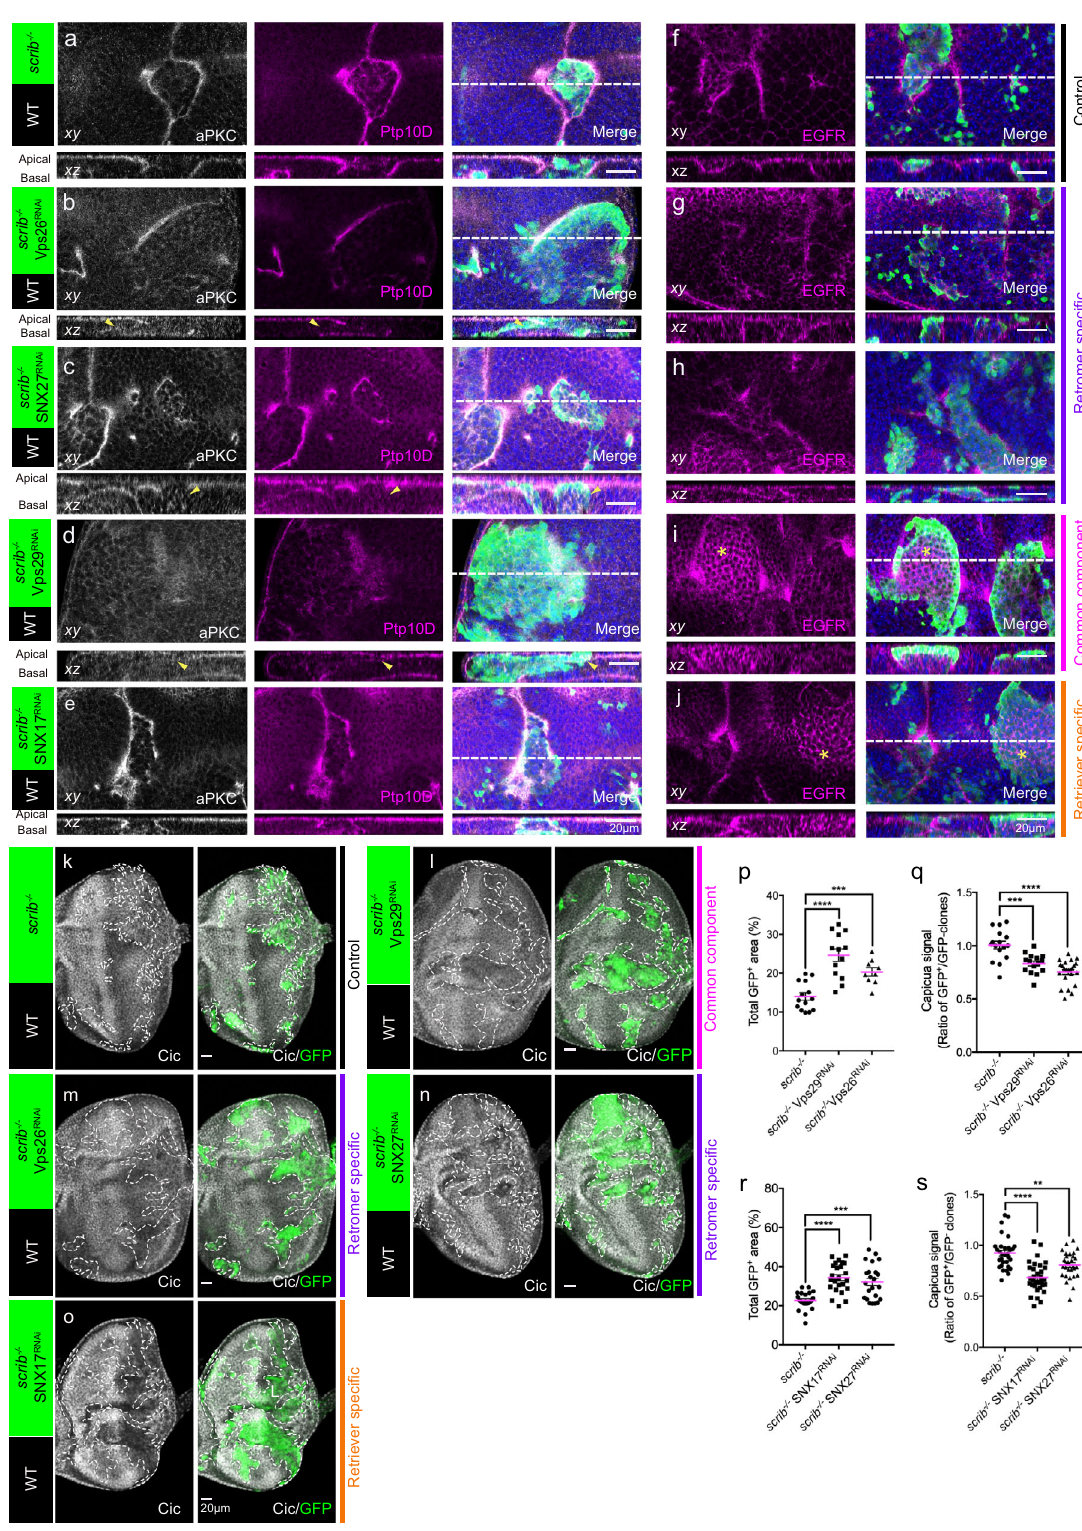
Western blot analysis 10wingdiscsweredissectedfromthirdinstarlarvaeandhomogenized in 10 μ l of RIPA buffer and Protease inhibitor cocktail tablets